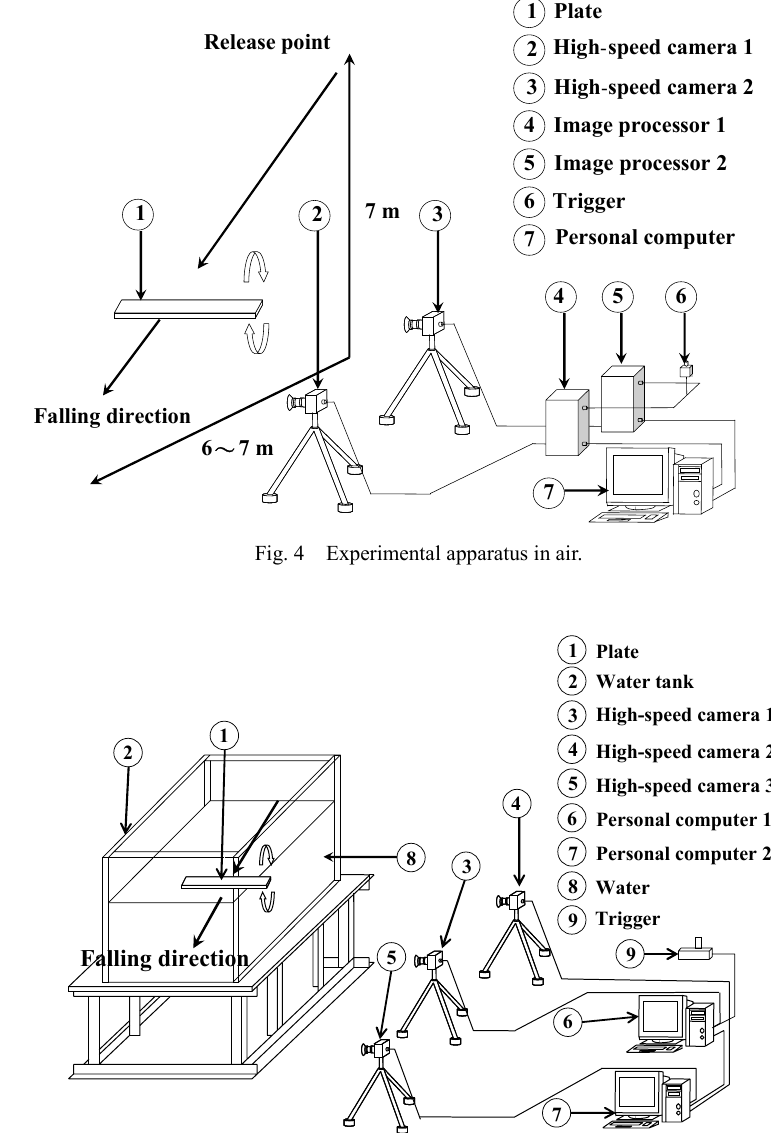
Fig. 5 Experimental apparatus in